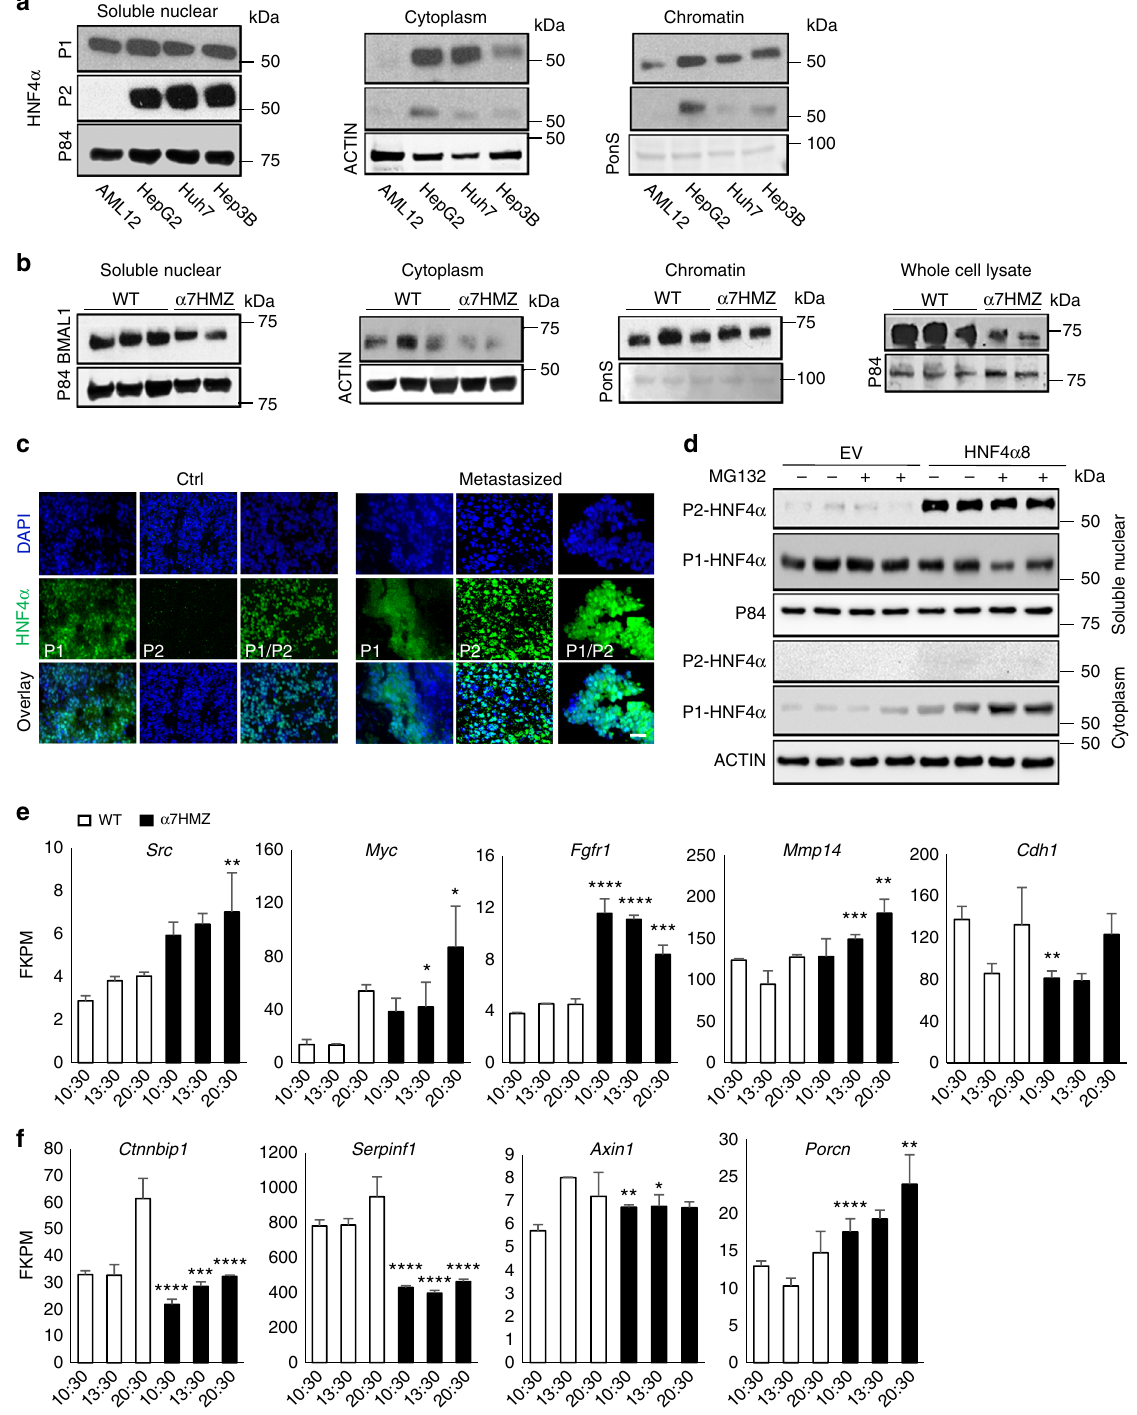
Fig. 5 Altered subcellular localization of HNF4 α isoforms in HCC. a Western blot shows the expression of P1-HNF4 α and P2-HNF4 α in the soluble nuclear, cytoplasmic, and chromatin fractions of AML12, hepatoblastoma, and HCC lines. b Western blot showing the expression of BMAL1 in cellular compartments and whole cell lysates of mice expressing exclusively P1-HNF4 α (WT) or P2-HNF4 α ( α 7HMZ mice) (PonS = ponceau S). c Immuno fl uorescence of control tissue and metastasized human HCC specimens with antibodies speci fi c to P1-HNF4 α , P2-HNF4 α , or to P1/P2-HNF4 α . d Western blot showing P2-HNF4 α and P1-HNF4 α localization to the soluble nuclear compartment or the cytoplasm following overexpression of P2- HNF4 α in AML12 cells. e FKPM counts from RNA-seq for Src , Myc , Fgfr1 , Mmp14 , and Cdh1 mRNAs in WT or α HMZ livers. f FKPM counts from RNA-seq for Ctnnbip1 , Serpinf1 , Axin1 , and Porcn in WT or α HMZ livers. * P < 0.05, ** P < 0.01, *** P < 0.001, **** P < 0.0001, ( N = 3). Scale bar is 50 µ m. Error bars =